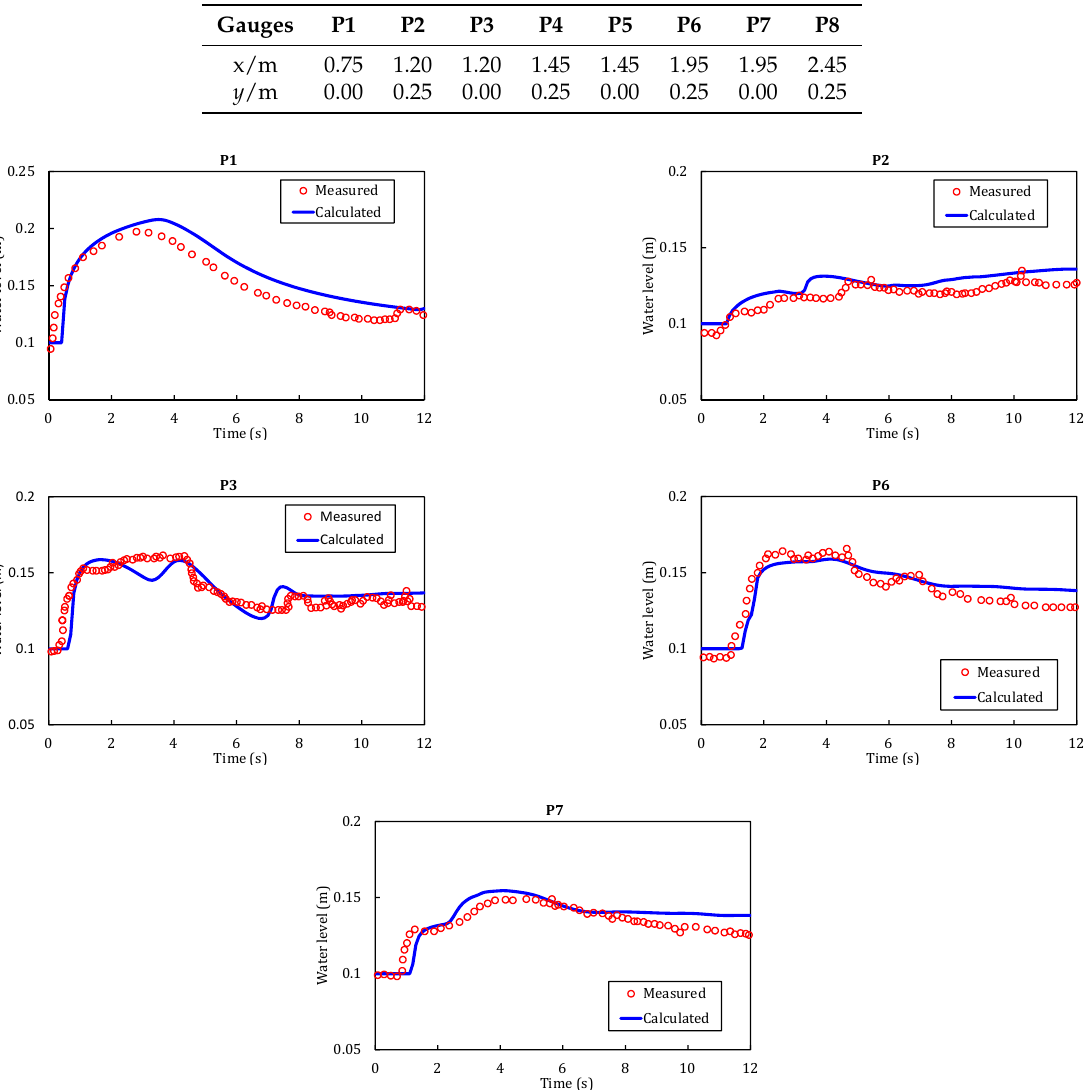
Table 2. Coordinates of ultrasonic gauges for experiment of dam-break flow in an erodible channel with a sudden enlargement.